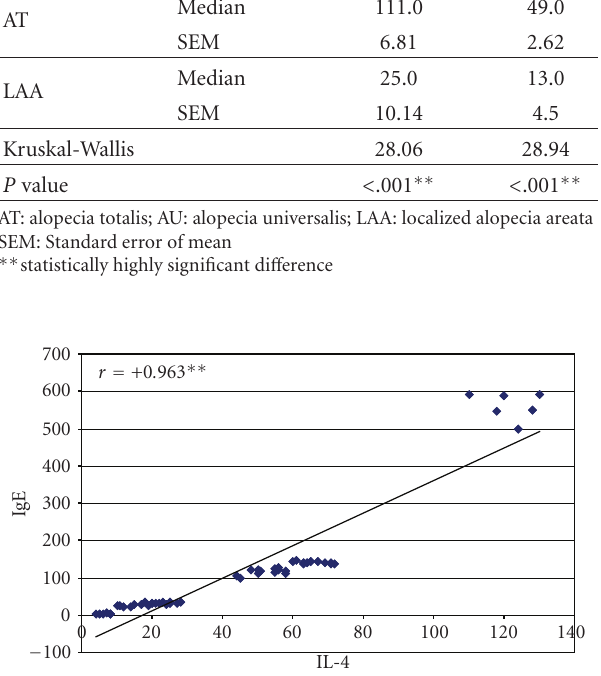
Figure 1: Correlation between serum IL-4 and IgE among the studied patients.